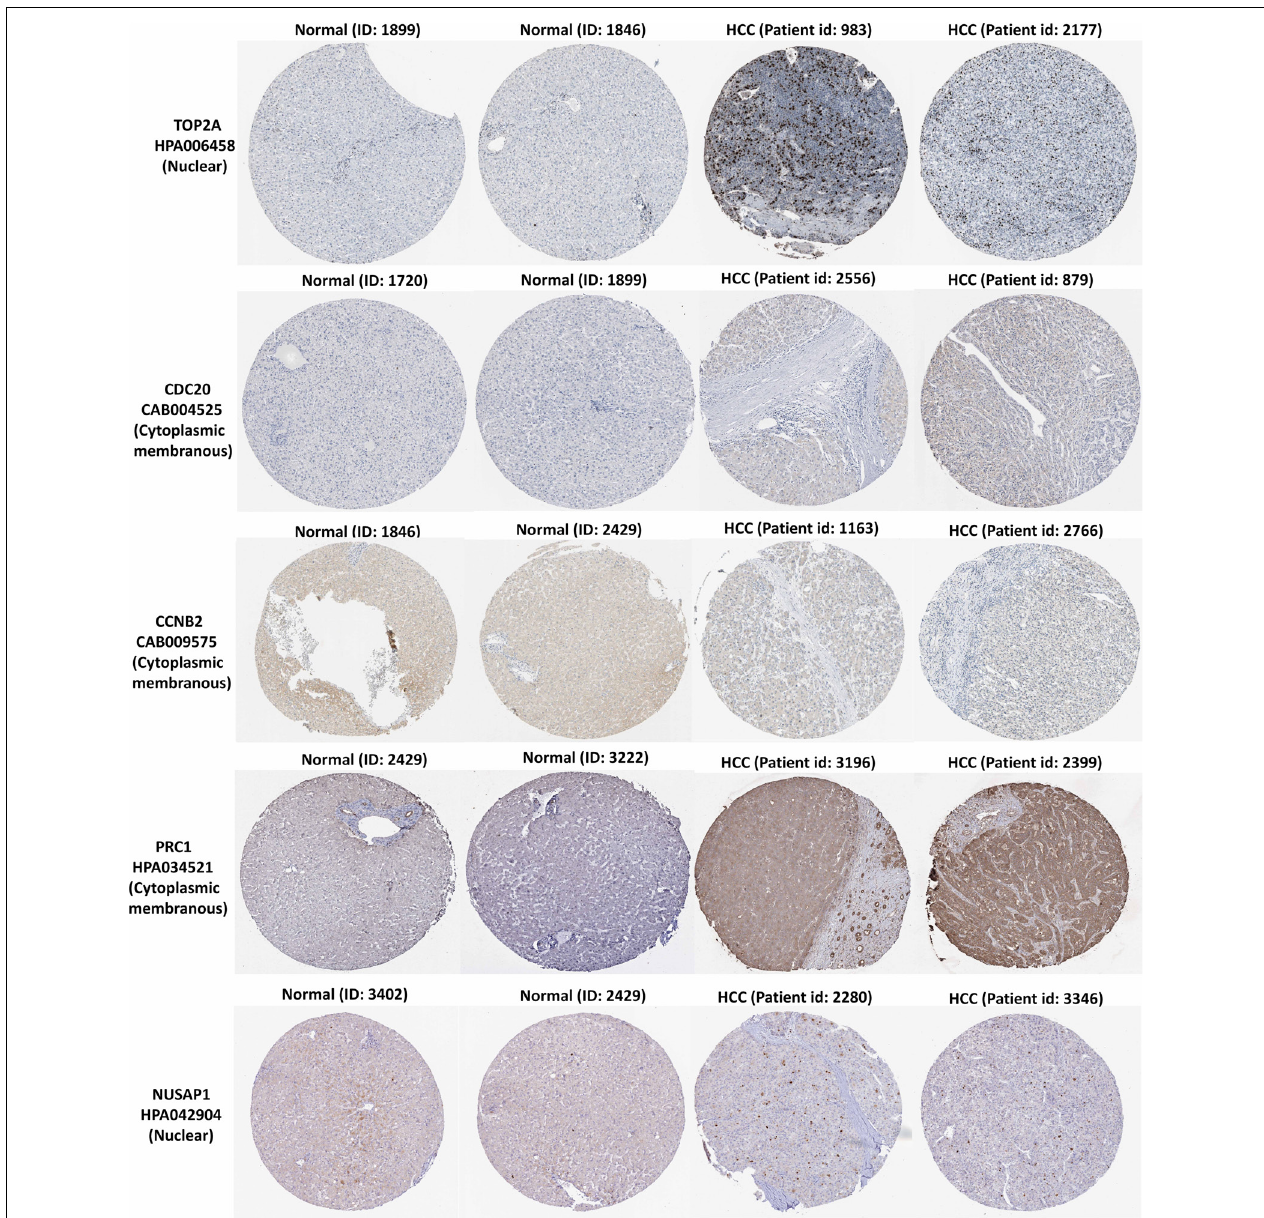
FIGURE 7 | TOP2A, CDC20, PRC1, CCNB2, and NUSAP1 proteins expression in normal and HCC tissues from the HPA database. Selected immunohistochemistry images of proteins (TOP2A, PRC1, and NUSAP1) detected in HPA database that showed almost negative staining in normal tissue but rather high expression in HCC tissue. Magnification, 100 × . HCC, hepatocellular carcinoma; HPA, Human Protein